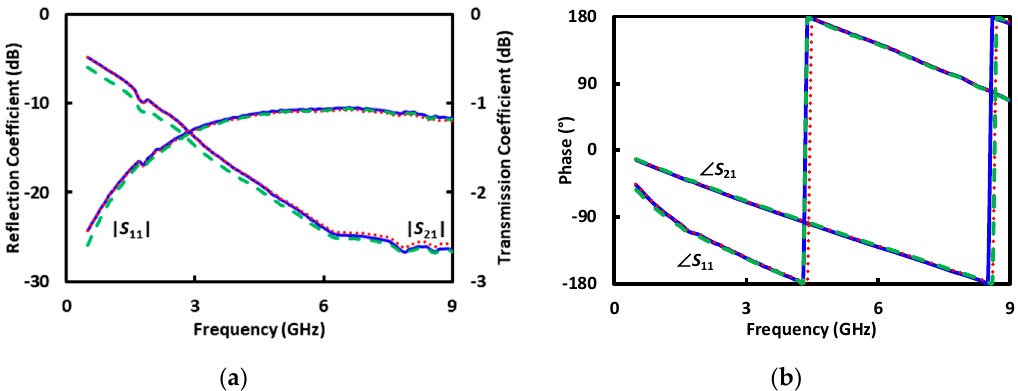
Figure 2. ( a ) Magnitude and ( b ) phase of measured S parameters of the centimeter-long CPW with the microfluidic channel filled with DI ( ‒‒ ), sucrose ( · · · ), or RPMI ( - - - ) solutions.